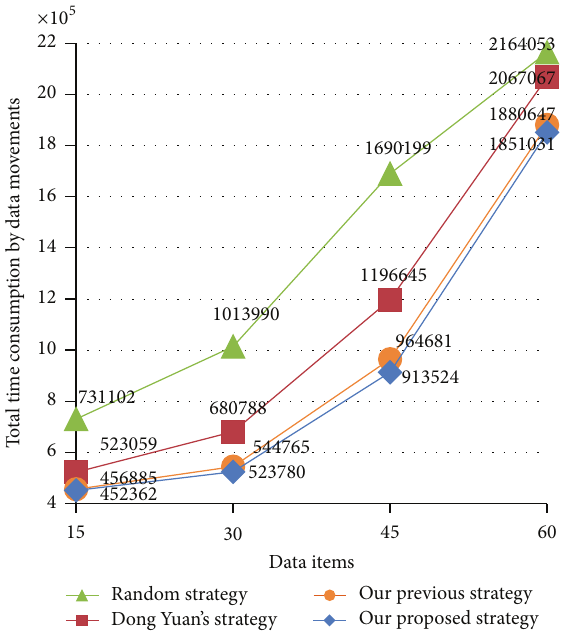
Figure 4: Total data movement amount without fixed-position datasets.